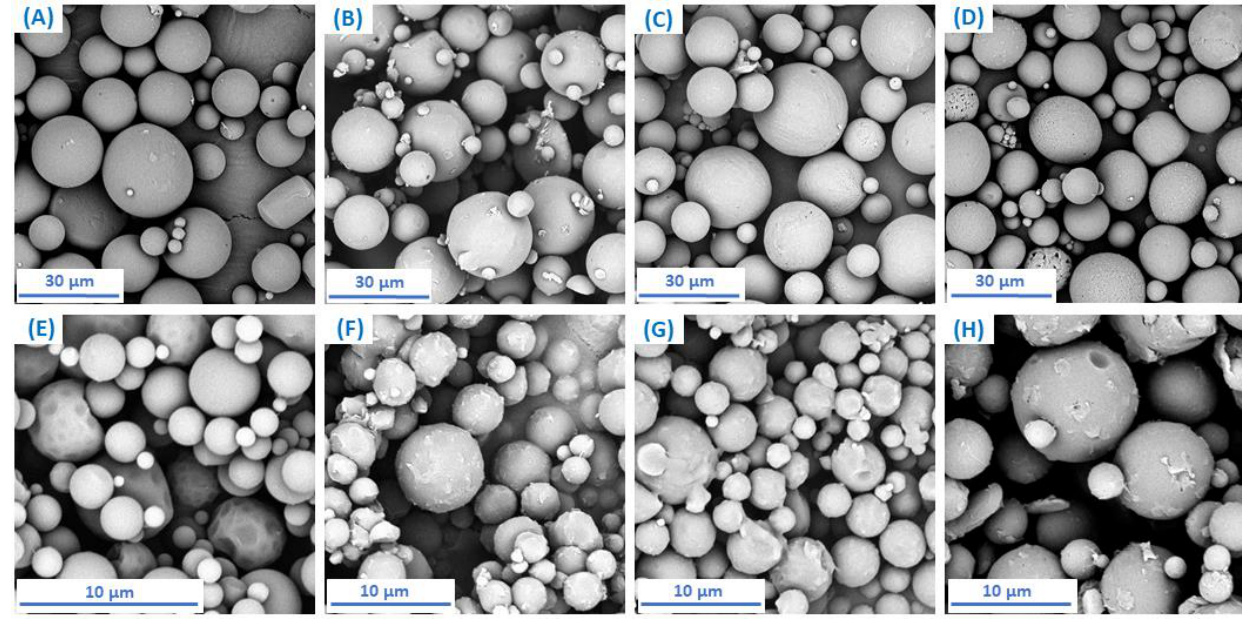
Figure 7. SEM images of RIF – MS obtained from: SEB_20_3 ( A ); SEB_40_3 ( B ); SEB_60_3 ( C ); SEB_80_3 ( D ); SEB_20_6 ( E ); SEB_40_6 ( F ); SEB_60_6 ( G ); SEB_80_6 ( H ).